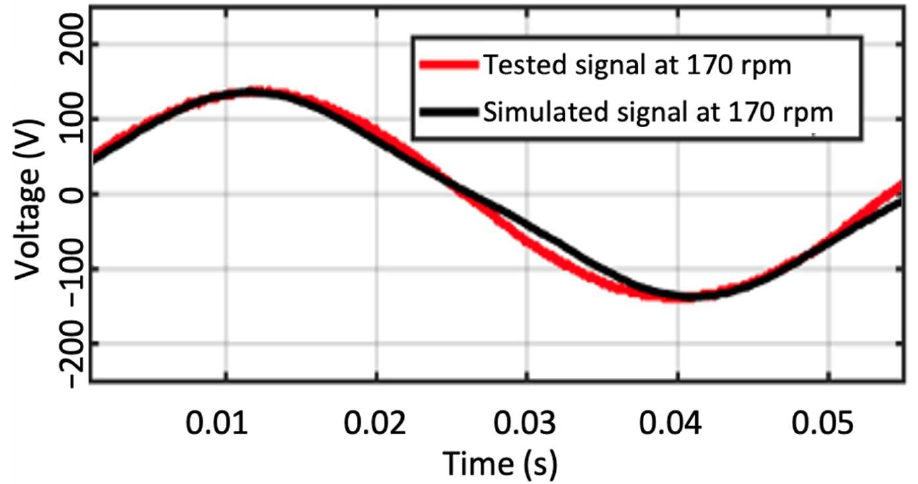
Figure 8. Voltage signals under simulation and test conditions.